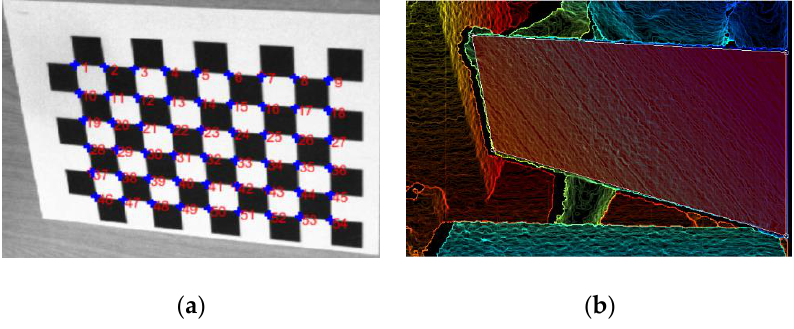
Figure 3. The key steps in the operation of the program. ( a ): the detection of corners—there are 54 corners of our checkerboard; ( b ): selected the four corners of the calibration plate—the manually selected plane coincides with the plane of the calibration plate.